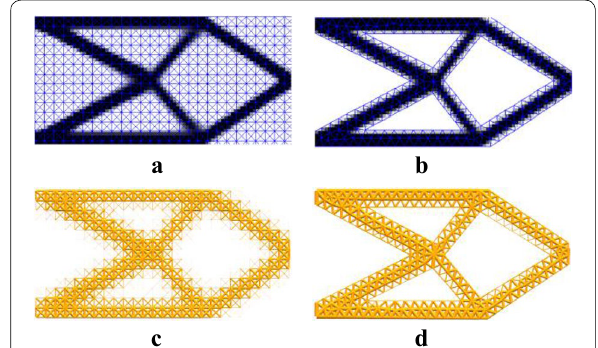
Figure 6 Generated 2D lattice structures using RDM and LRDM methods: a RDM 2D mesh; b LRDM 2D mesh; c RDM 2D lattice structures; d LRDM 2D lattice